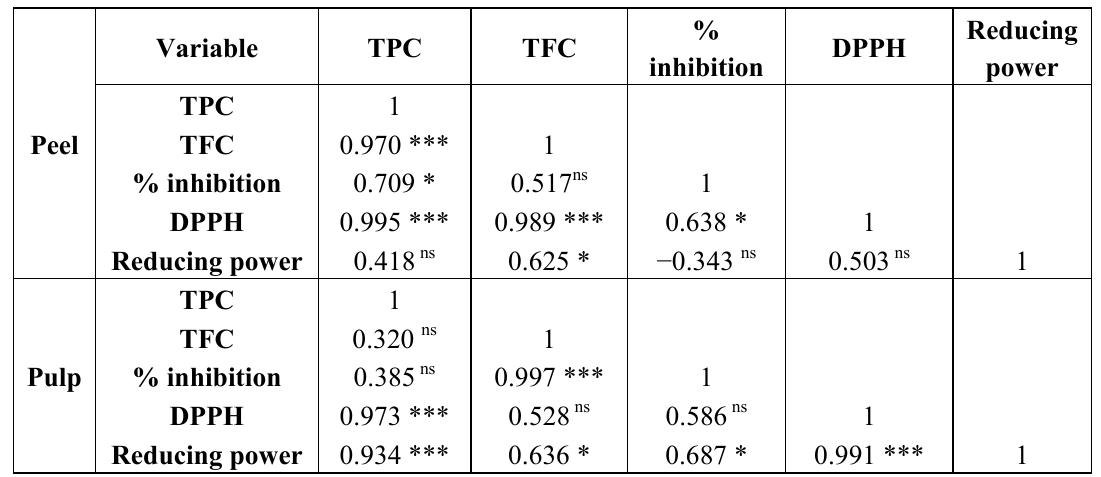
Table 4. Comparison of results from different antioxidant assays as represented by correlation